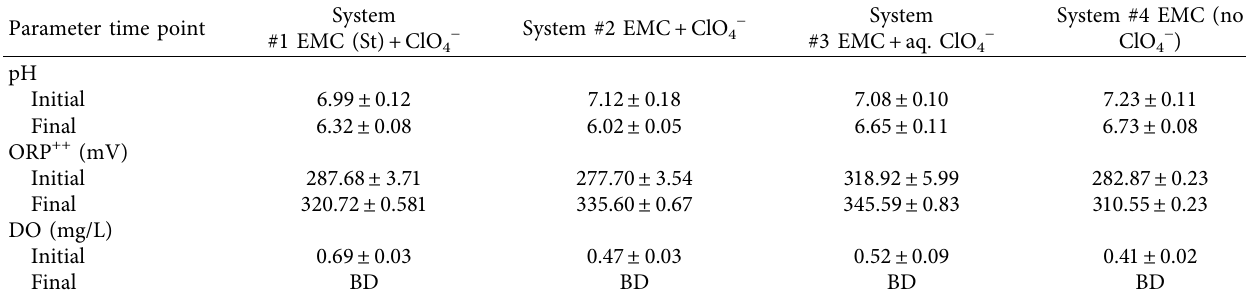
− , from spent MR with EMC over 7d at 25 ° C. 4